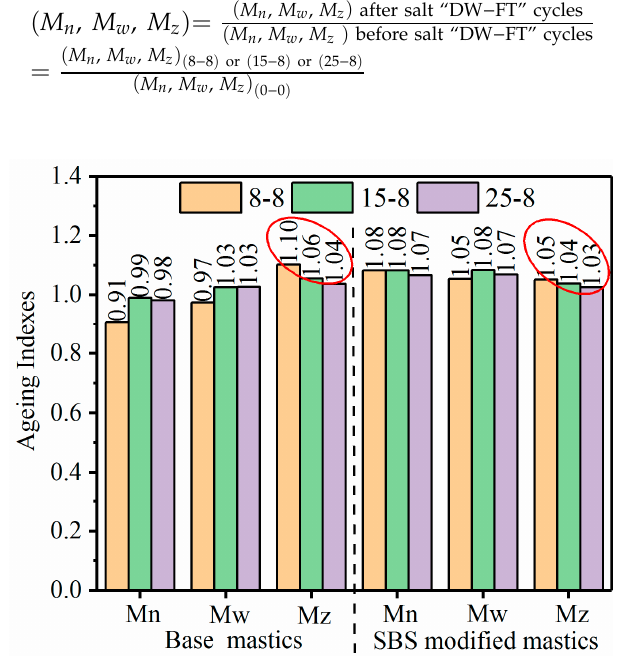
Figure 11. The ageing indexes of the mastics.